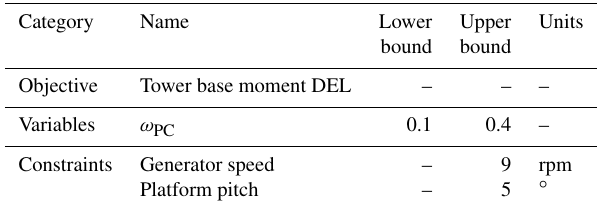
Table 3. Optimization problem formulation for the controls opti- mization